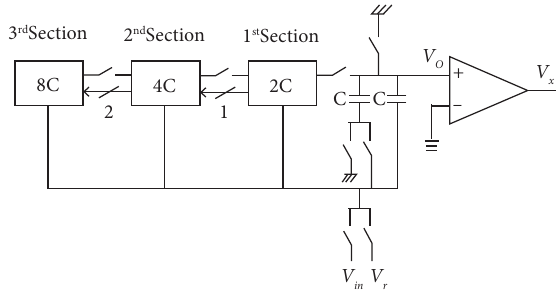
Figure 22: Hybrid and junction splitting